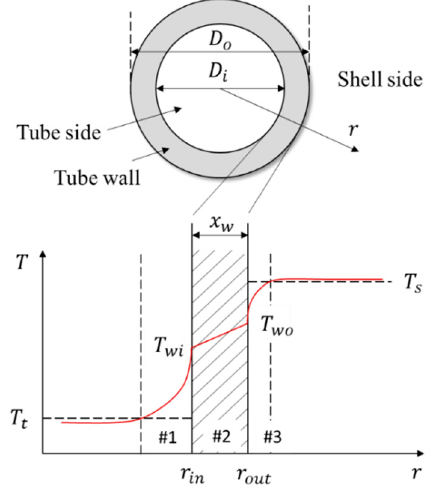
Figure 2. Cross section of single tube and radial temperature profile.